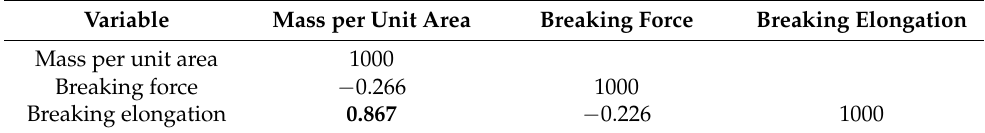
Table 6. The correlation coefficients—mass per unit area, breaking force and breaking